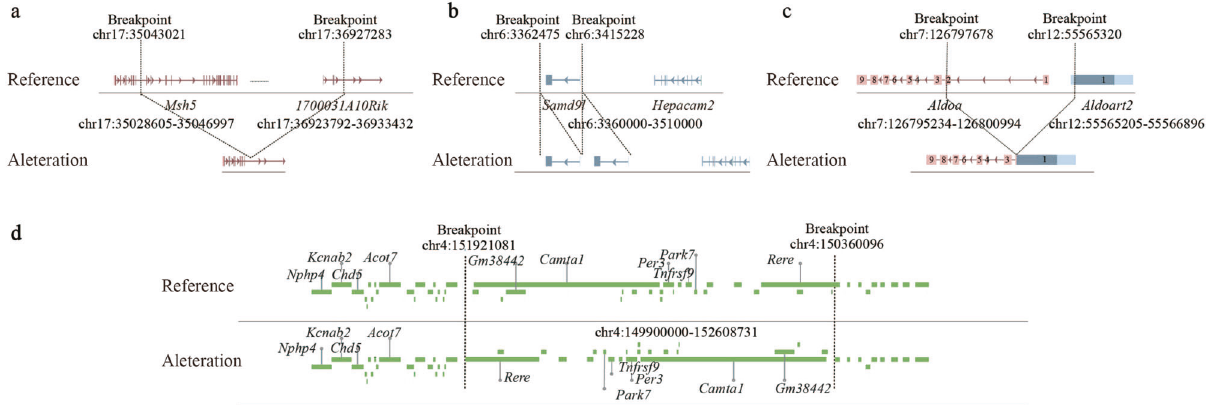
Fig. 5 Examples of SV-disrupted genes. a A deletion between Msh5 and 1700031A10Rik at the 4th month formed Msh5-1700031A10Rik out-of- frame fusion. b A duplication in Samd9 occurred at 16.5 embryonic days. c A t(7:12) translocation at the 4th month formed an out-of-frame Aldoa-Aldoart2 fusion. d Normal Rere structure VS the inversion at 16.5 embryonic days disrupted Rere The PCR primers used for genotyping Brca1 (Table S1): Primer 1- F1: 5 ′ -CTGGGTAGTTTGTAAGCATCC-3 ′ ,